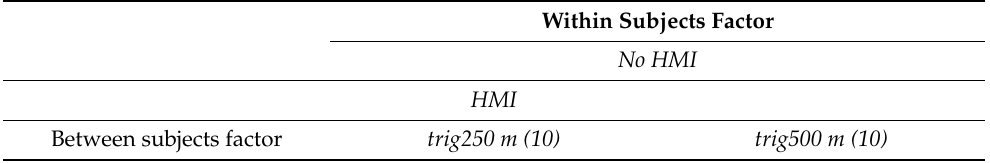
Table 1. Mixed within and between subjects experimental design. The number of participants per condition is shown in parentheses. Within Subjects Factor No HMI HMI Between subjects factor trig250 m (10) trig500 m